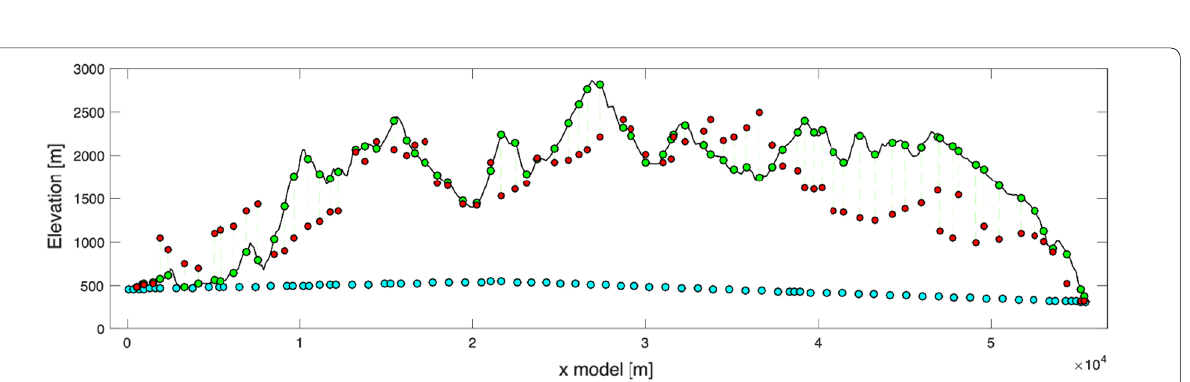
Fig. 4 2D topographic profile along the reference model line (see location in Fig. 2), showing the projected tunnel gravity data points (cyan circles) and the projected surface gravity data points (green circles). The surface gravity measurements points at their original measurement elevation are shown as red circles. Prior to comparison with synthetic values, computed at the projected locations (green circles), the gravity data points are corrected for the effects due to this projection. The procedure in explained in detail in Sect.